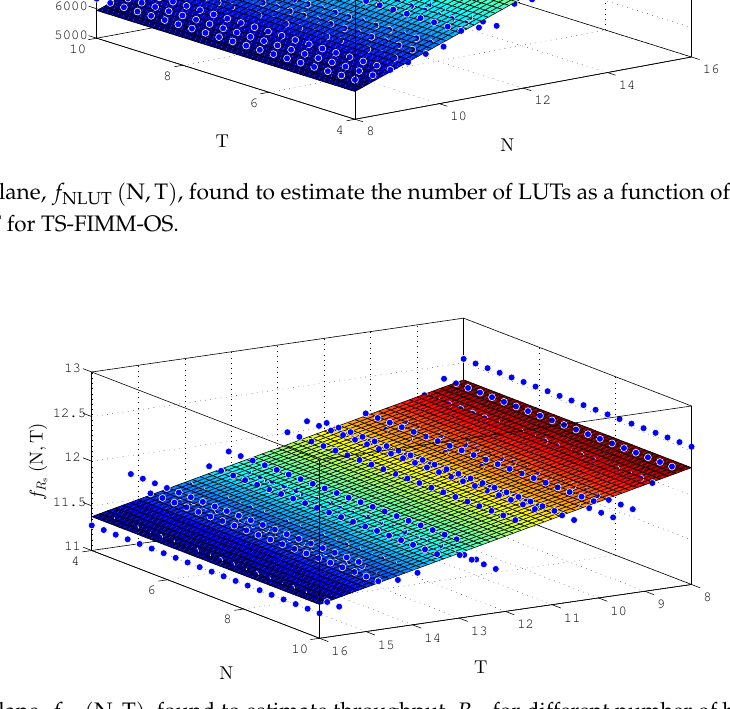
Figure 15. Plane, f R